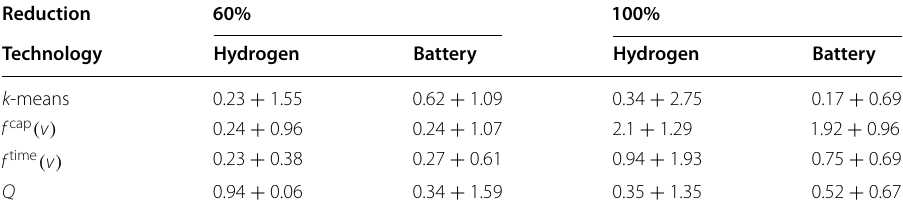
Table 10 Analogous to Table 8, however with a spatial resolution of 127